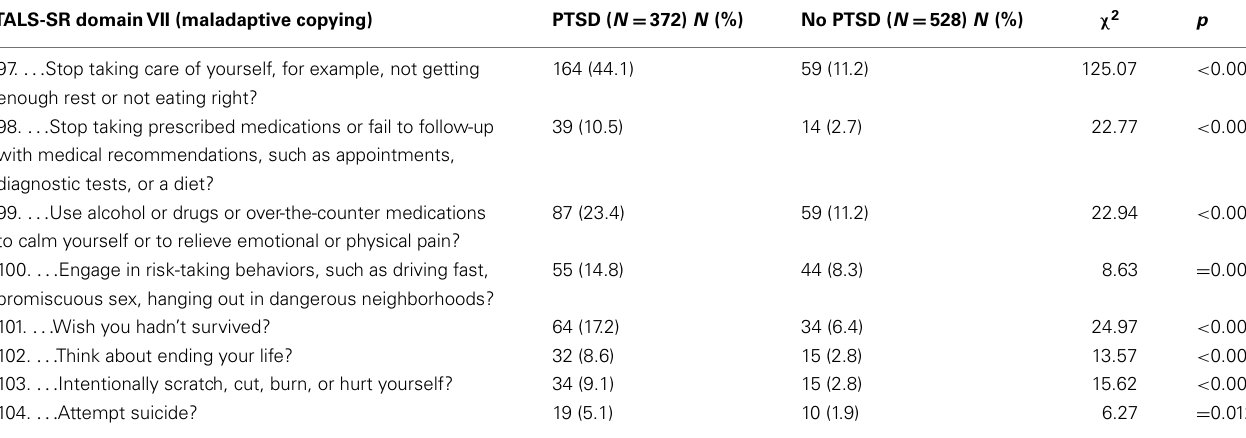
Table 1 | Maladaptive behaviors (TALS-SR DomainVII) prevalence rates in 900 L’Aquila earthquake survivors: PTSD vs. No PTSD. TALS-SR domainVII (maladaptive copying)